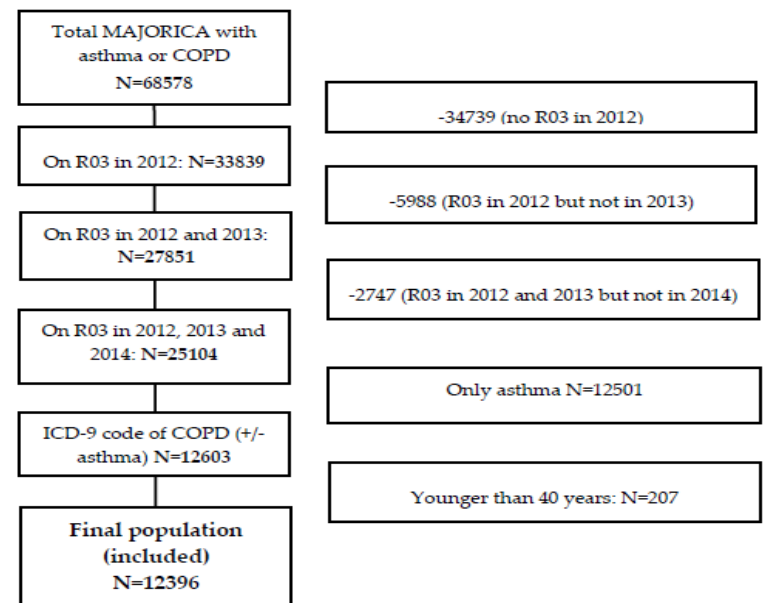
Figure 1. Flow chart for selection of study sample.